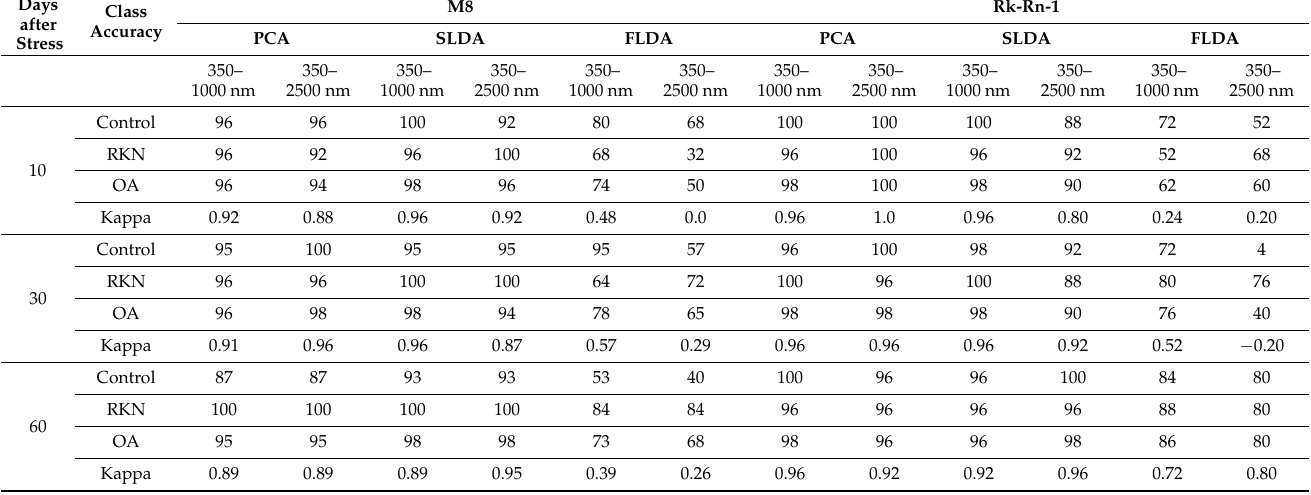
Table 1. Classification accuracies for a two-class problem (M8 vs. Rk-Rn-1) using leaf spectral reflectance information between 350–1000 nm and 350–2500 nm measured at 10, 30, and 60 days after stress treatment in 2020.